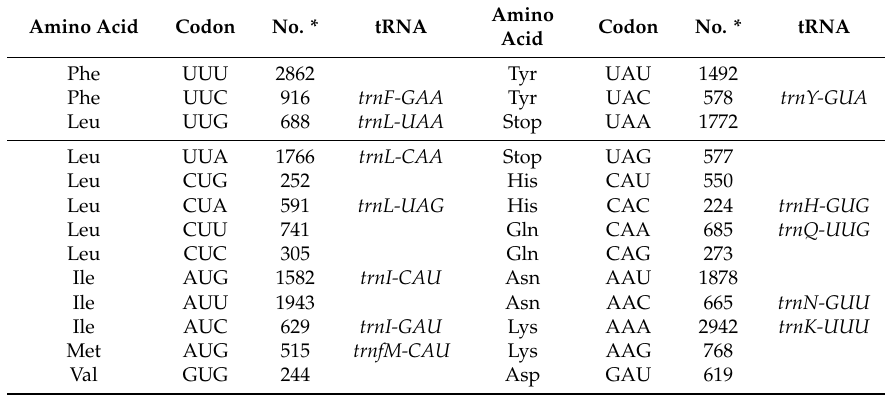
Table 3. The codon-anticodon recognition pattern and codon usage for S. uncinata plastome. Amino Acid Codon No. * tRNA